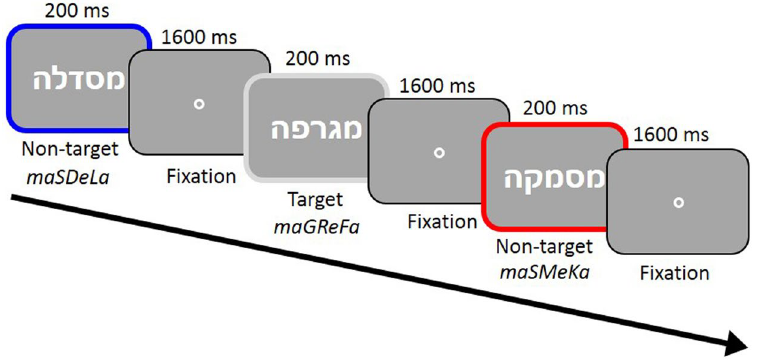
Figure 1. Trial structure and experimental conditions. Stimuli were presented in Hebrew unpointed script (the standard form of presentation for adult readers), in white font on a gray background. Participants performed a word detection task (push a button when the stimulus is an existing word in Hebrew, and do not respond otherwise). Stimulus condition is denoted by frame color: Invented-root pseudowords (blue), Real-root pseudowords (red) and Words (gray) which served as targets in this task. No colors were used in the actual stimuli. The phonetic transcription of each stimulus is presented below it, with the root letters in uppercase. The full list of stimuli may be obtained from the